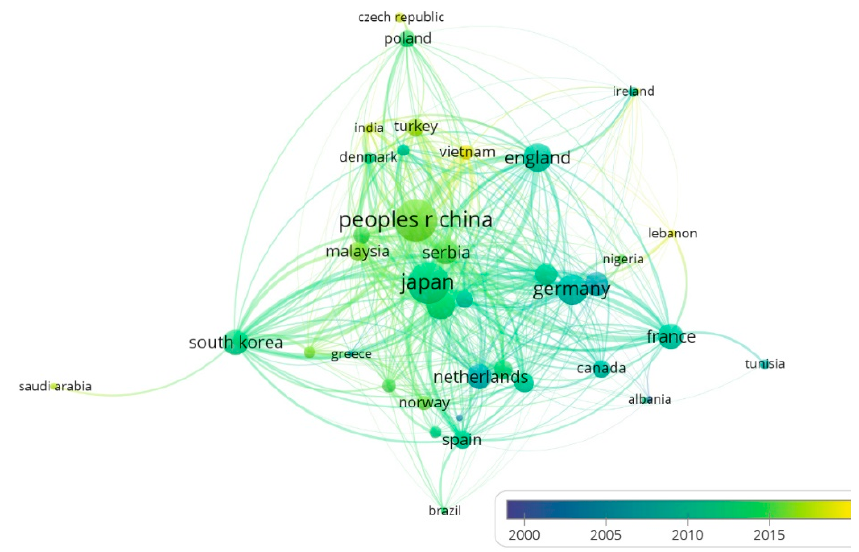
Figure 7. The collaboration network visualization map of the 42 representative countries.